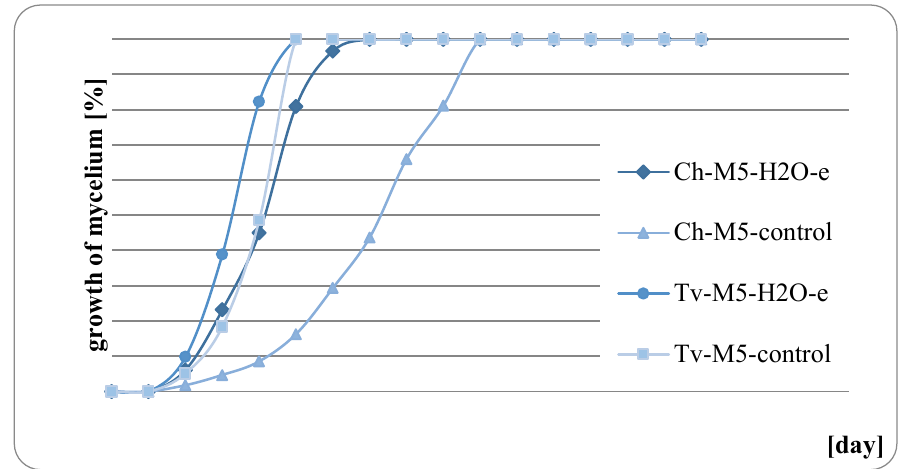
Figure 10. Growth of fungi on M. spicata ‘Crispa’ with and without extraction.